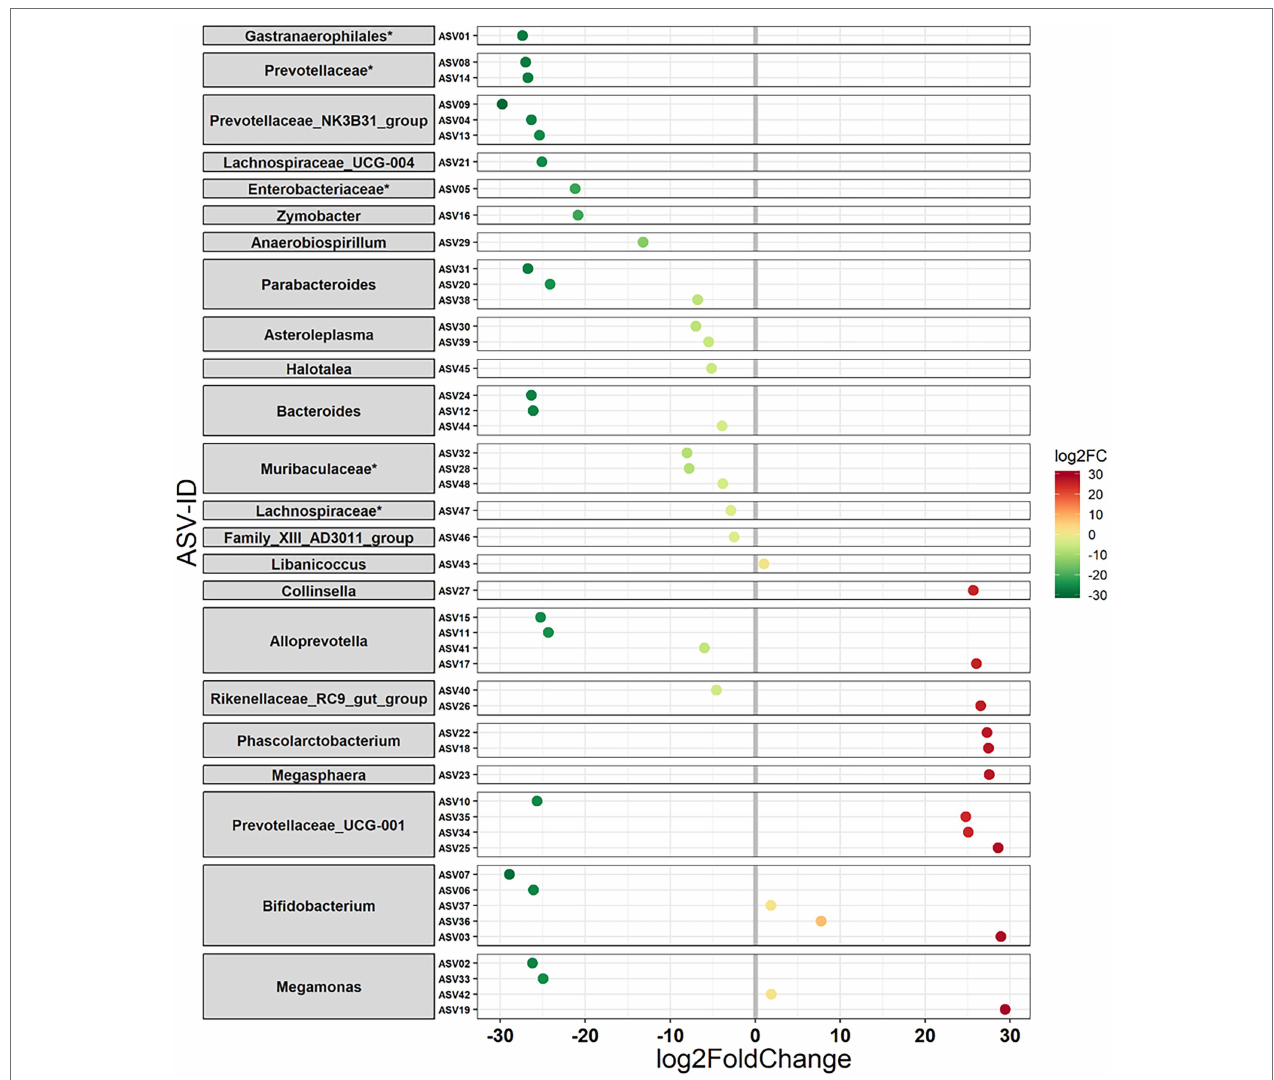
FIGURE 5 | Differential abundance of amplicon sequence variants (ASVs) in mouse lemurs inhabiting two different habitats. ASVs (48 ASVs) that differ in their mean abundance in relation to the habitat of mouse lemurs. Values indicate a log 2-fold (log2FC) decrease (33 ASVs) or increase (15 ASVs) in Miarintsoa individuals. ASVs are arranged according to increasing values of log2FC. The highest possible taxonomic assignment (maximal to the genus level) is shown for each ASV; *includes unclassified ASV/s at genus